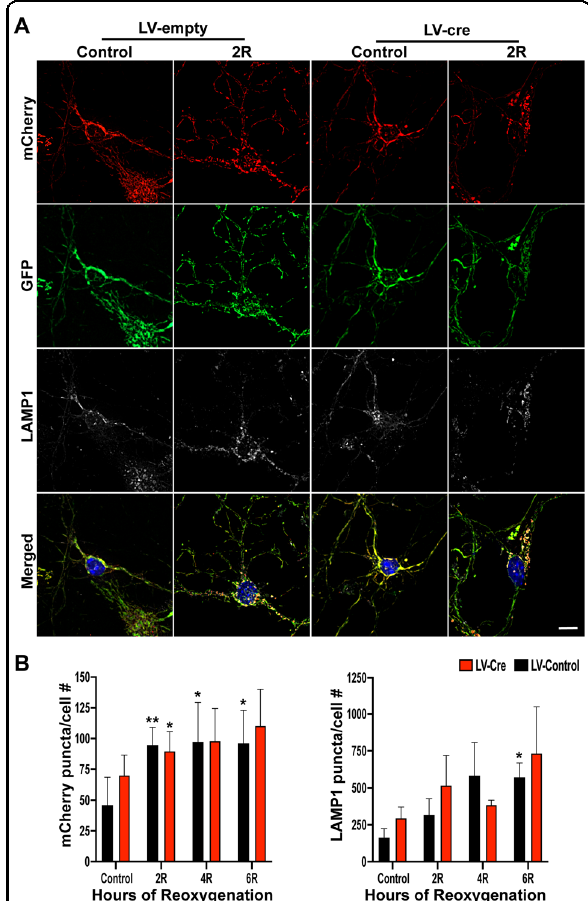
Fig. 5 Mitophagic fl ux is independent of Drp1. A Representative images of Drp1 fl / fl / QC Ki/ + primary cortical neurons, infected with either LV-EF1a-empty or LV-EF1a-cre, subjected to OGD/R and analyzed for the presence of mCherry puncta. B Quanti fi cation of mCherry puncta per cell and total LAMP1 puncta per cell during OGD/R. Two-way ANOVA was used to detect differences across time and between conditions. Multiple comparisons across time were assessed by comparing the means of each time point with the mean of the control and were calculated using Dunnett ’ s post-hoc analysis. Multiple comparisons between conditions were computed using Sidak ’ s post-hoc analysis. * p < 0.05; ** p < 0.01 across time, # p < 0.05 between condition, n = 8 biological replicates per group. Scale bar = 10